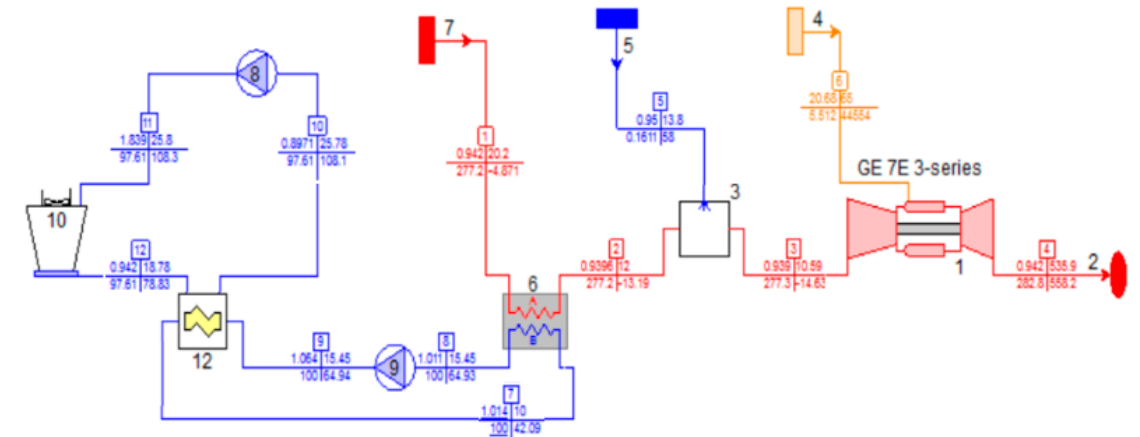
Figure 10. Gas turbine with hybrid vapor-compression refrigeration evaporative inlet cooling.